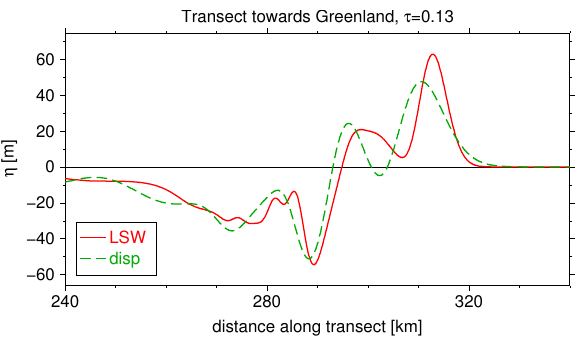
Fig. 13. Computations of the waves generated by the Hinlopen sub- marine landslide along a transect towards Greenland. The front of the waves has traveled 420km from the landslide area over an aver- age depth of about 2km. Waves are propagating to the right (south- west).